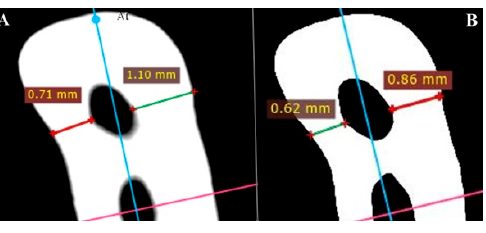
Figure 5. Measurements of root canal transportation ( A ) before instrumentation and ( B ) after instrumentation.